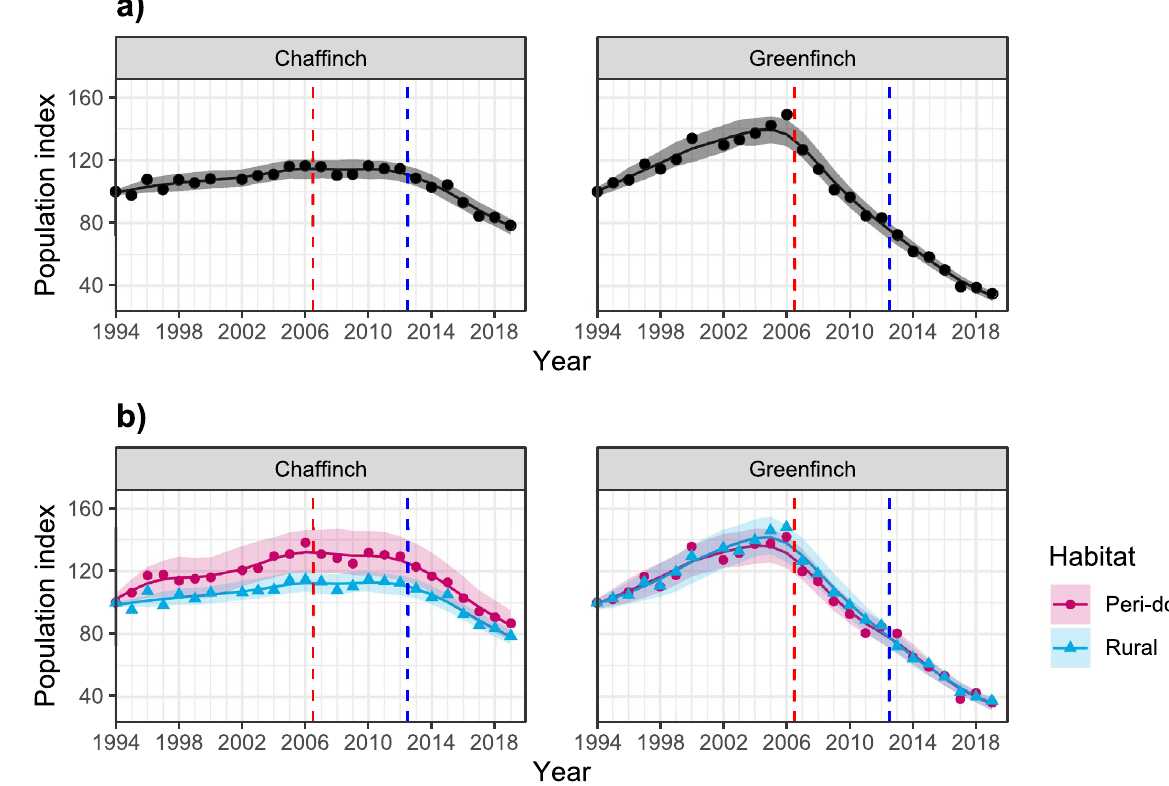
Figure 1. Breeding Bird Survey (BBS) population index trends for chaffinch and greenfinch for ( a ) GB overall (adapted from Woodward et al. 32 ) and ( b ) GB survey sites identified as peri-domestic or rural (i.e. all other) habitat (BTO unpubl. data). The vertical, red, dashed line indicates the start of the greenfinch decline and chaffinch plateau period (early decline period), while the vertical, blue, dashed line indicates the start of the chaffinch decline period (late decline period). Plotted with 95% confidence intervals and indexed from 1994 (the first year of the